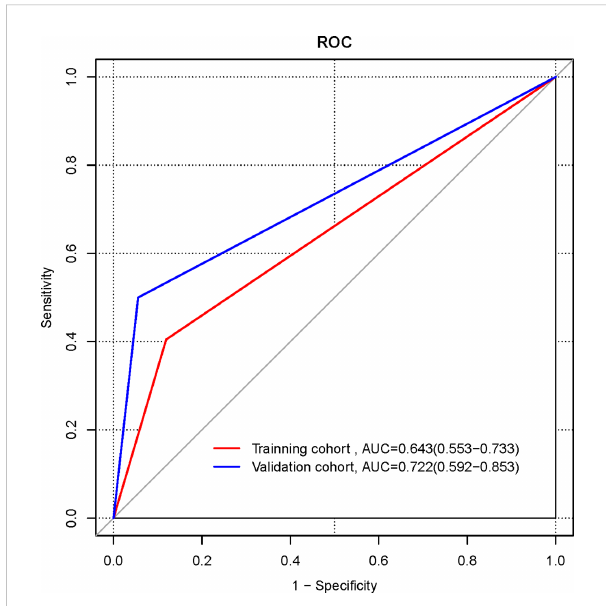
FIGURE 1 ROC curves of clinical model in the training and validation cohorts.